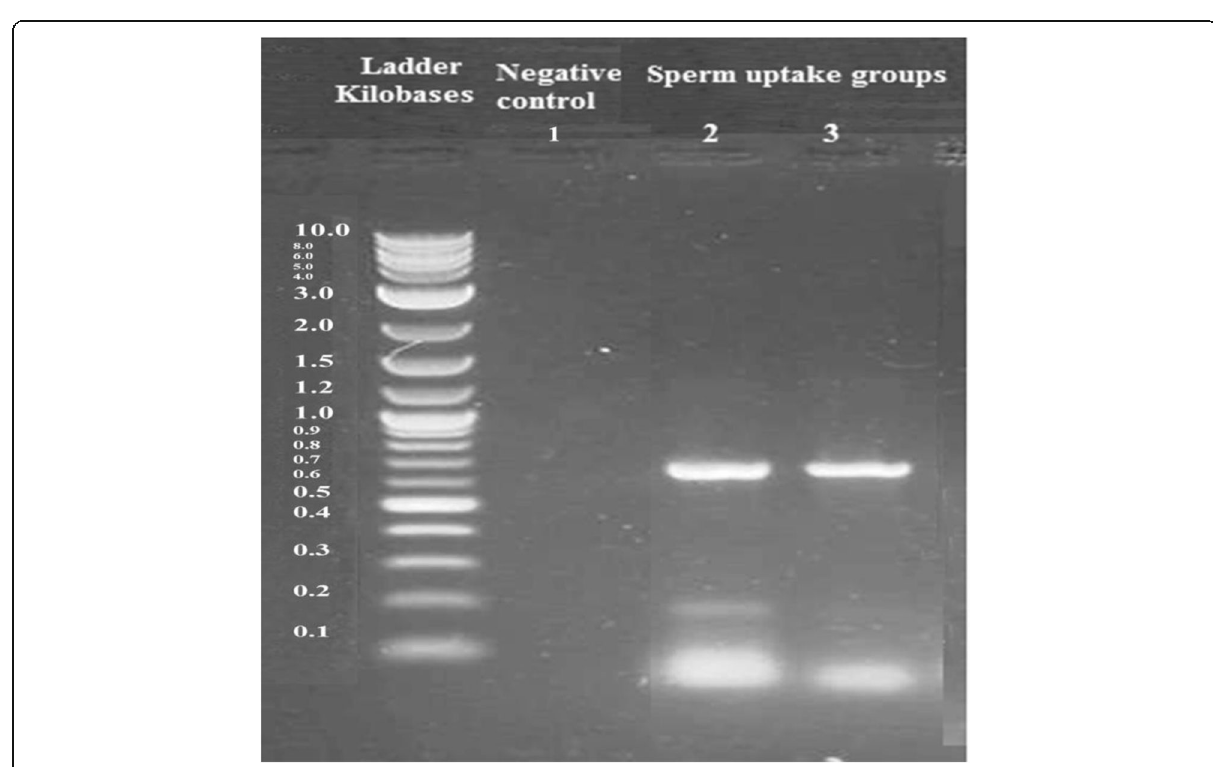
Fig. 7 Electrophoretic pattern of the EH_GH – pmkate2 – N vector after sperm uptake using mKate primer (PCR, 690 bp). Line 1, negative control group (sperm cells incubated without vector at 37 °C for 1 h). Line 2, positive control group (sperm cells incubated with vector at 37 °C for 1 h). Line 3, DMSO group (sperm cells incubated with vector and submitted to 3% DMSO then incubated at 37 °C for 1